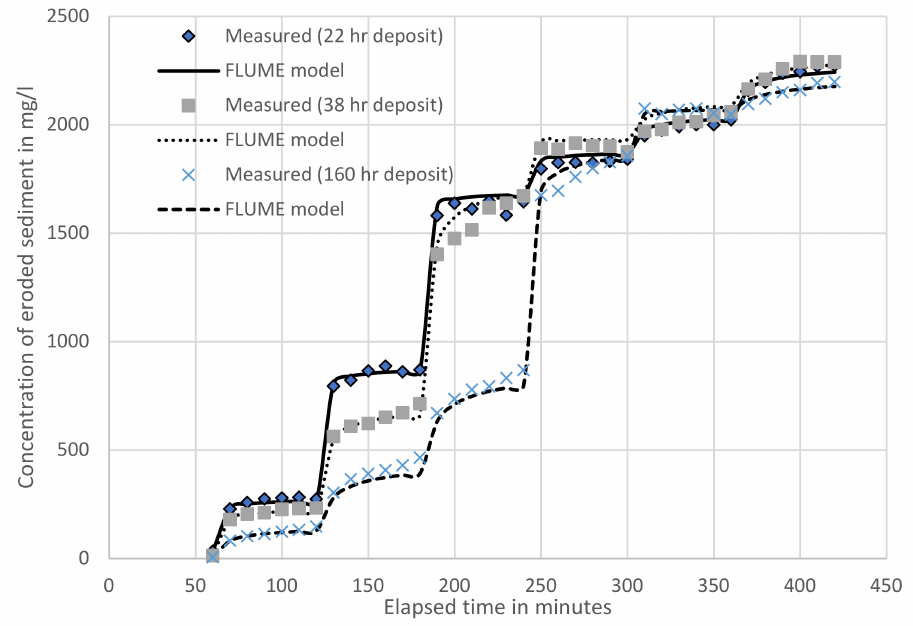
Figure 6. Comparison of measured and modelled sediment concentrations predicted by the FLUME